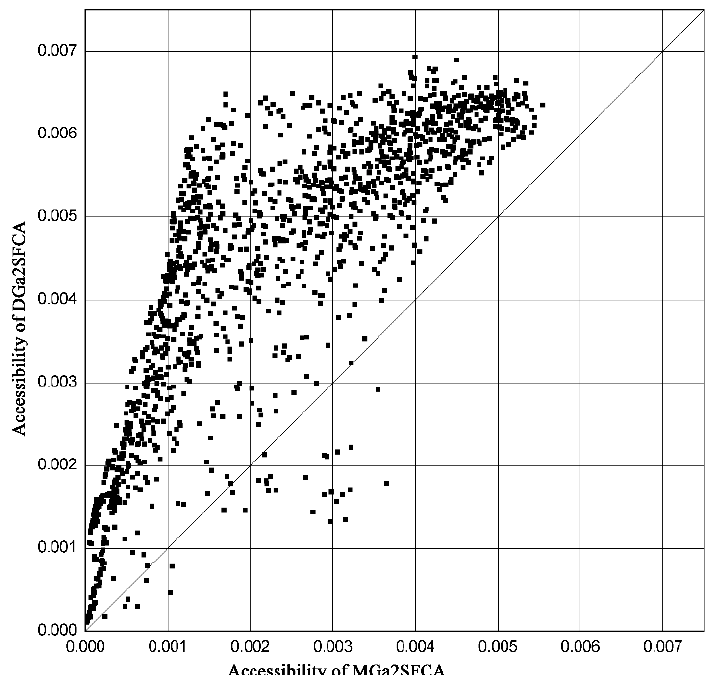
Figure 6. Accessibility comparison of the DGa2SFCA method and the MGa2SFCA method.